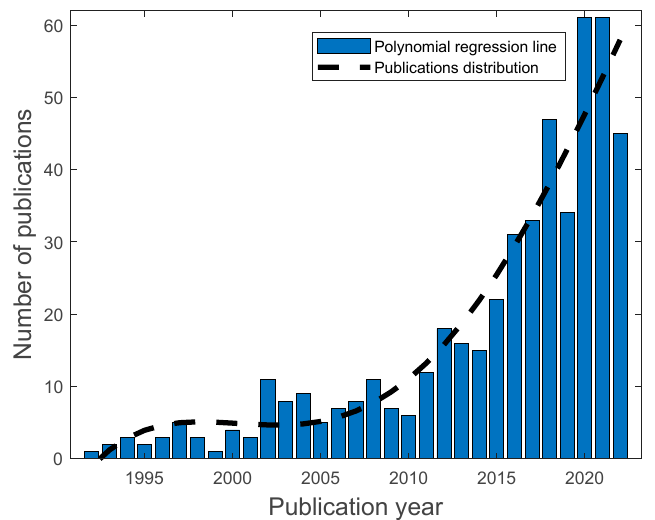
Figure 4. Annual production growth in CBD_NDT research from 1991 to 2022.